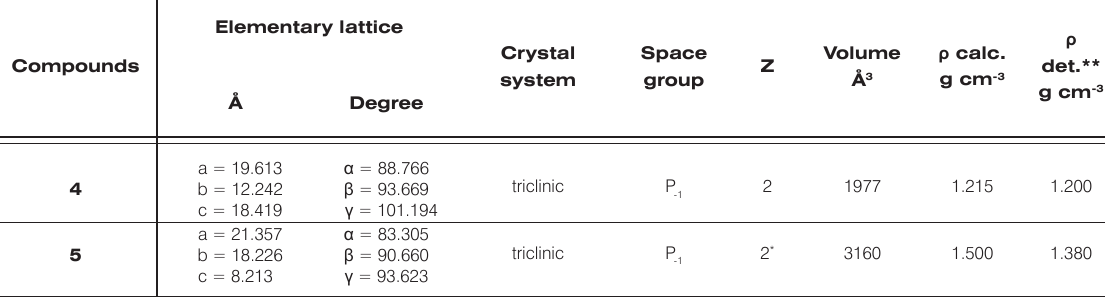
O) } ( 4 ) (down) 2 5 n ( 5 ) (up). n